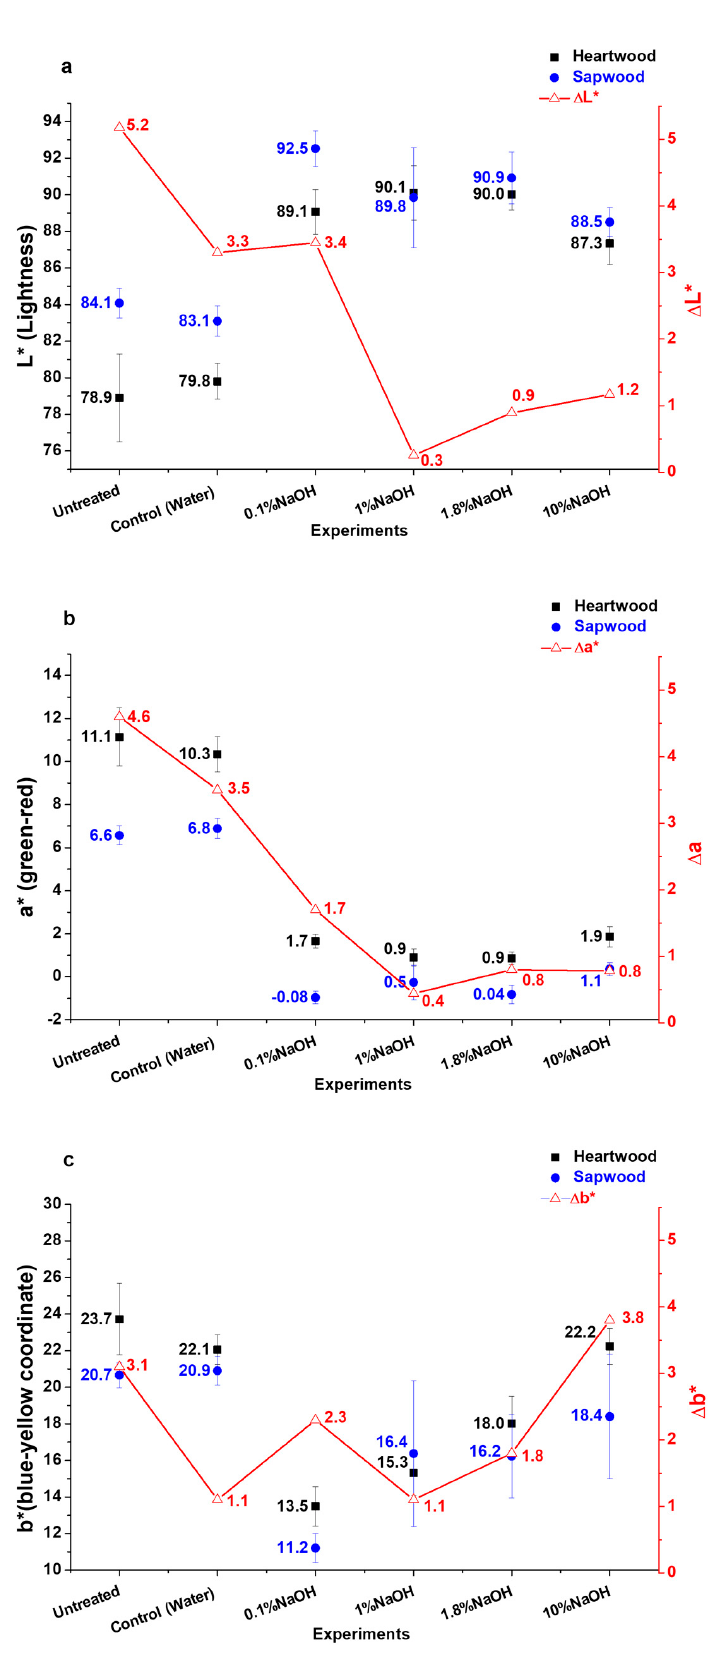
Figure 6. L* ( a ), a* ( b ), and b* ( c ) values evolution depending on NaOH concentration during H 2 O 2 treatment (4% H 2 O 2 , 0.4% Na 2 SiO 3 , 60 °C@1 h, mean of three replicates).